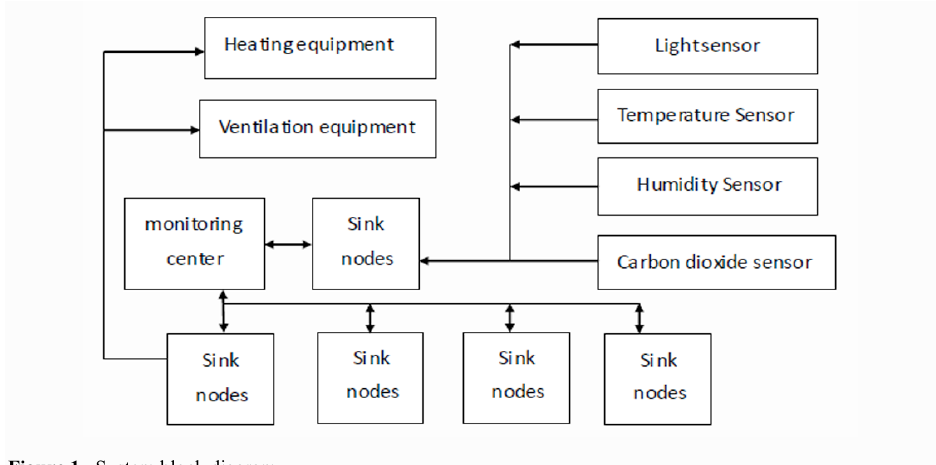
Figure 1. (cid:2) System block diagram